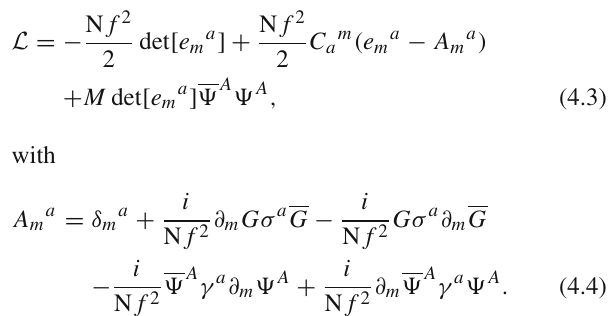
Table 1 Few instances of numerical solutions for stationary points of (3.18) with (cid:5) = 1, but without making any approximation on the effec- tive potential. The numerical solutions approach the analytic ones as we go closer to the parametric limits that allow our approximations. The